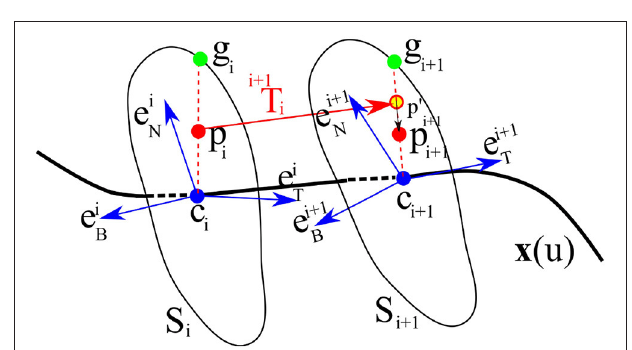
FIGURE 6 | Reproduction from a random initial pose p i on the i th cross-section